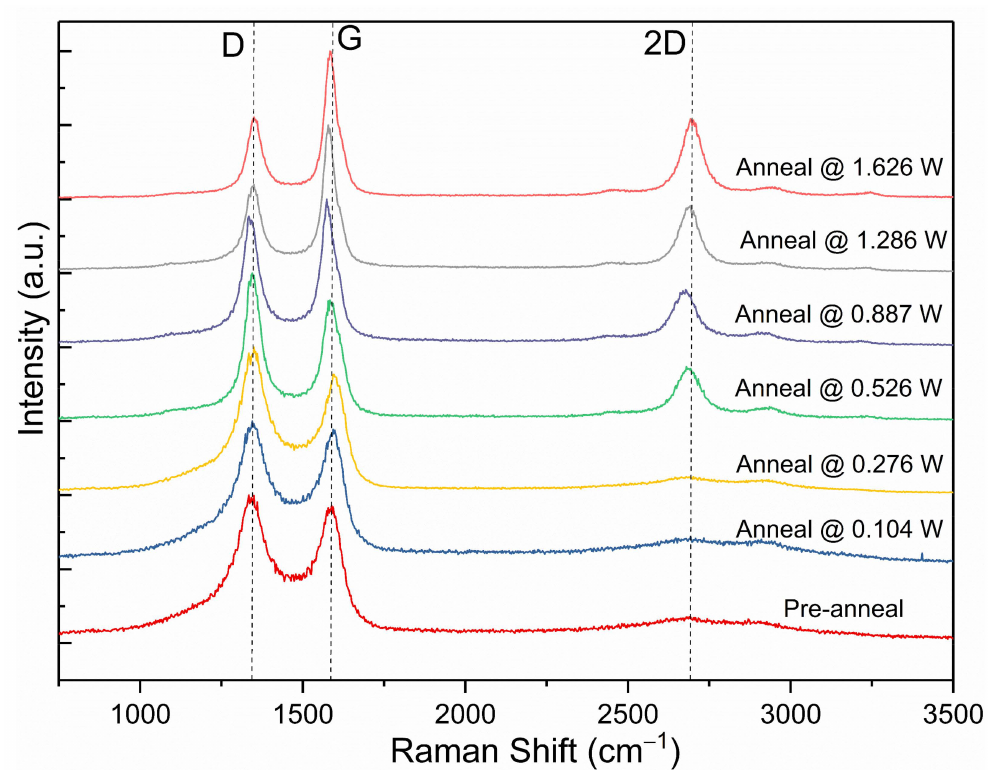
Figure 7. Raman spectroscopy comparison of carbon powder pre- and post-annealing at laser powers ranging from 0.104 W to 1.626